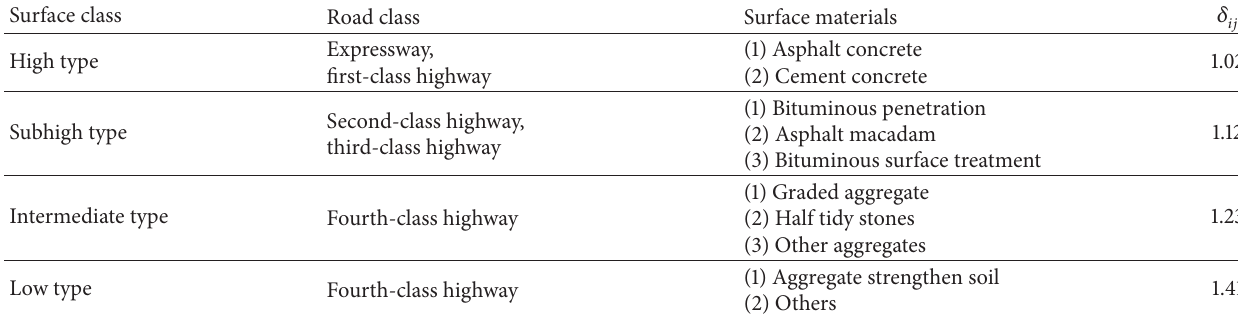
Table 1: Road class and evaluation